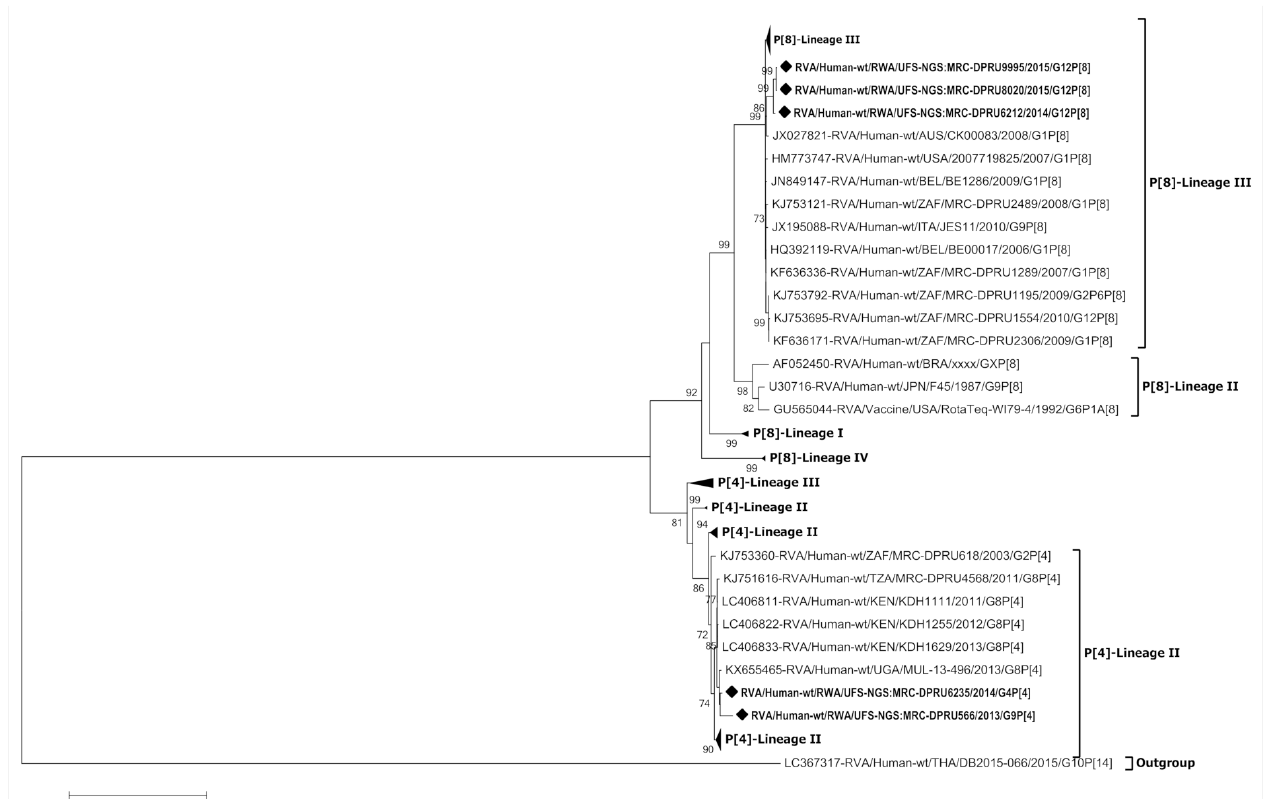
Figure 4. Phylogenetic relatedness of group A species based on VP4 of the study strains from Rwanda, P[4] and P[8]. The study strains are indicated with a black diamond. Bootstrap values ≥ 70% are indicated at each branch node. Scale bars represents substitutions per nucleotide